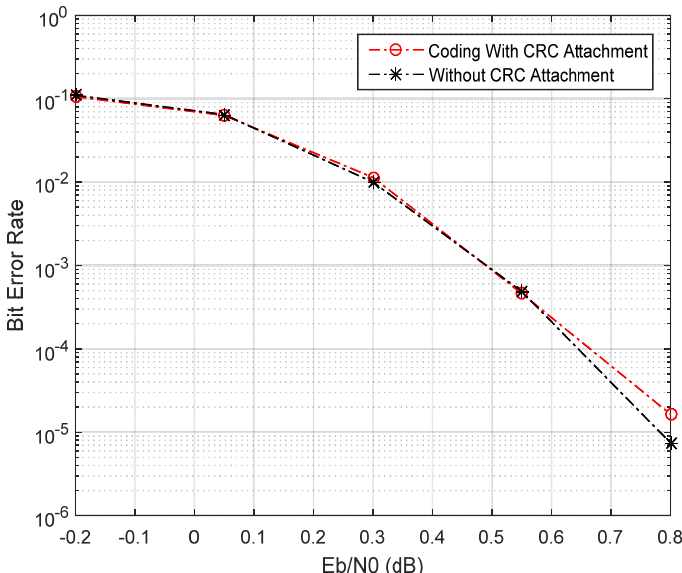
Figure 6. BER performance with CRC mechanism.